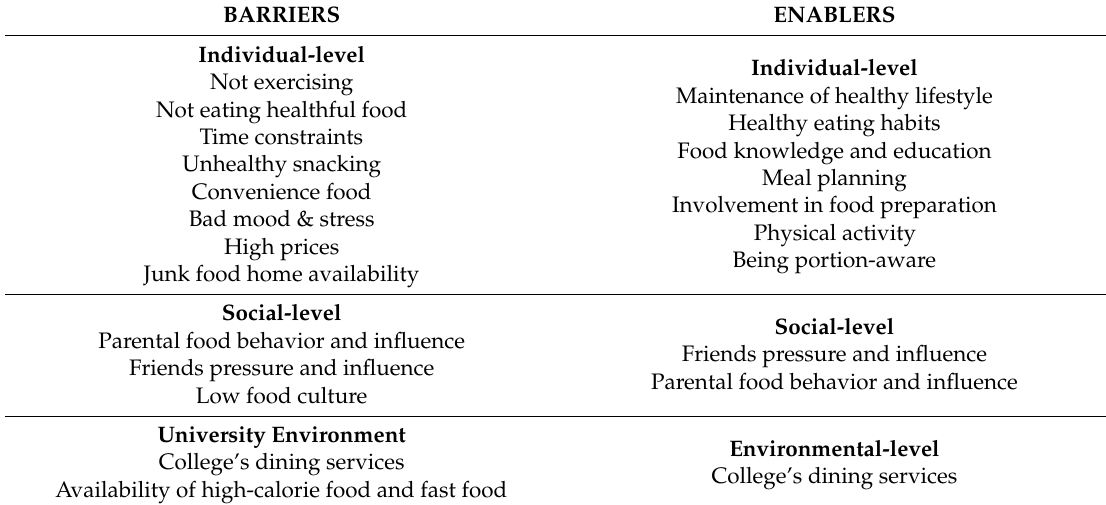
Table 4. Summary of the main barriers and enablers to a healthy diet among college students ( n =